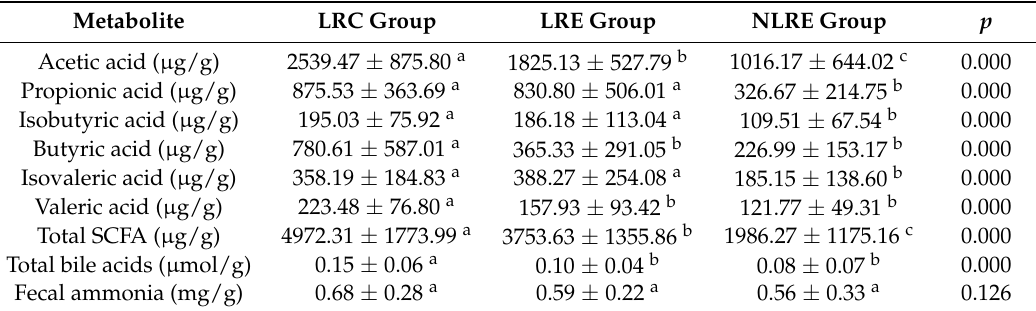
Table 3. Metabolites in feces in the LRC group, LRE group and NLRE group 1